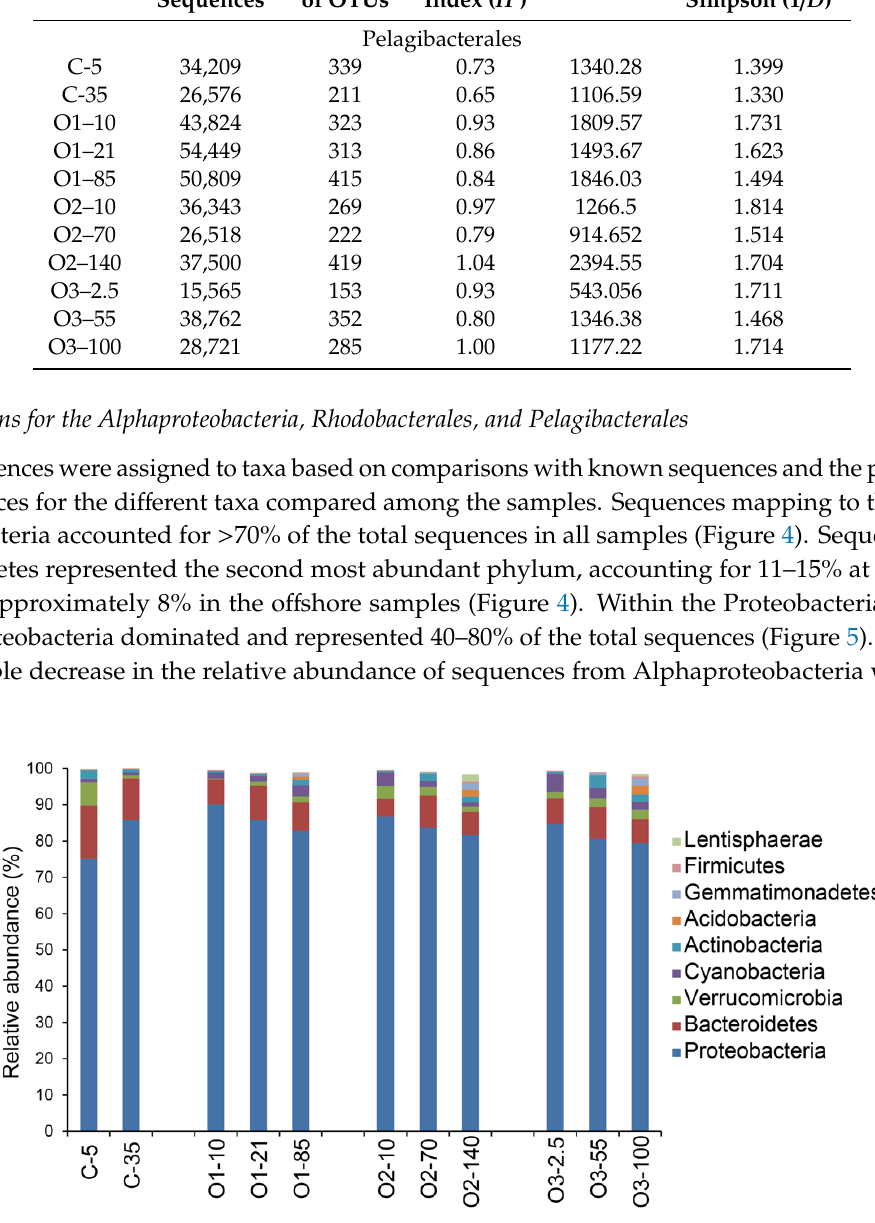
Figure 4. Community composition by bacterial phyla. The samples are indicated on the x-axis by sampling station (see Figure 1) and depth (m).